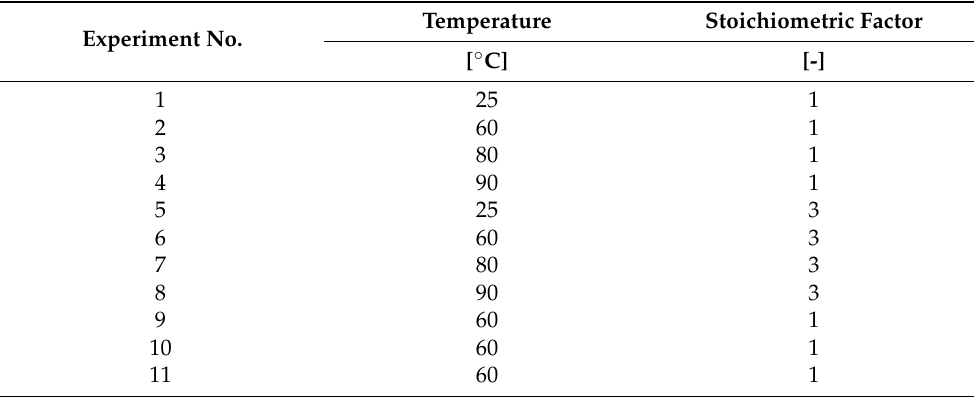
Table 3. Parameters of executed experiments for each precipitation agent (with a fixed holding period for each experiment of 60 min). Temperature Stoichiometric Experiment No.